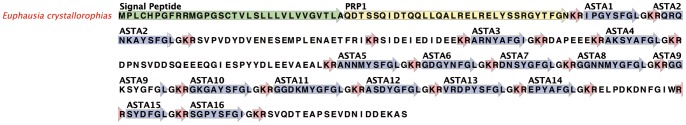
Complete protein sequence of the pre-pro-peptide containing the Allatostatin type As of d'E.
crystallorophias.The 16 Allostatin As are highlighted in blue and numbered according to their position in the sequence. The signal peptide is highlighted in green and the potential bibasic cleavage sites, in red. The latter delimit the 8 potential PRPs. The PRP highlighted in yellow was characterised by mass spectrometry.